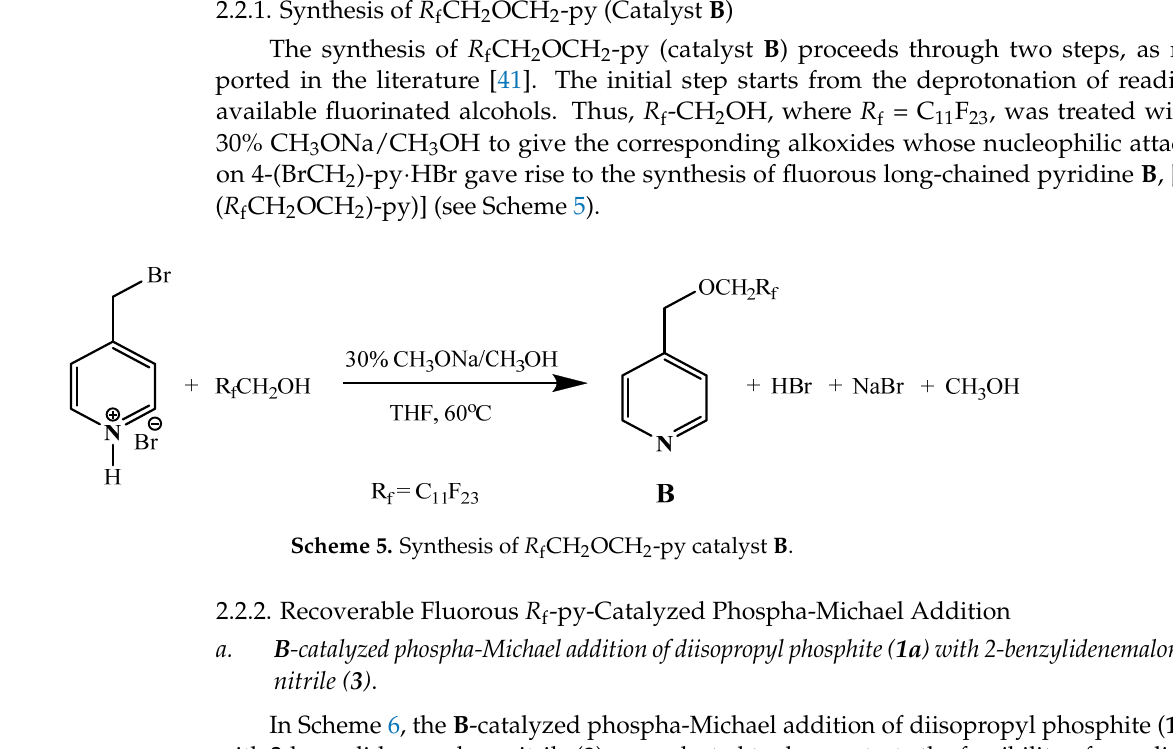
Table 7. Recycling results of B -catalyzed phospha-Michael addition of diisopropyl phosphite ( 1 ) with 2-benzylidenemalononitrile ( 3 ) at 80 °C. Scheme 6. The B -catalyzed phospha-Michael addition of diisopropyl phosphite ( 1a ) with 2-benzylidenemalononitrile-type substrates [ 3 (X = H), or 4 (X = CH 3